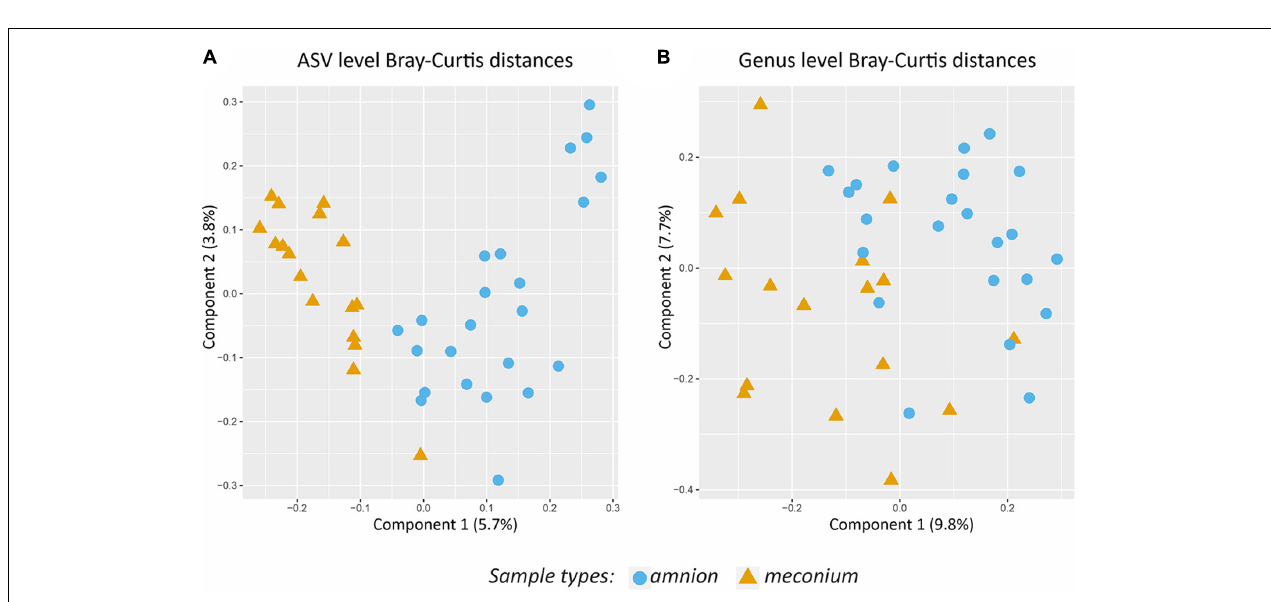
FIGURE 4 | Shannon diversity index showing the bacterial community structure (at genus level) of amniotic fluid and meconium samples, collected during elective C-section in Belgian Blue cow-calf pairs. Boxplot as in Figure 1 .